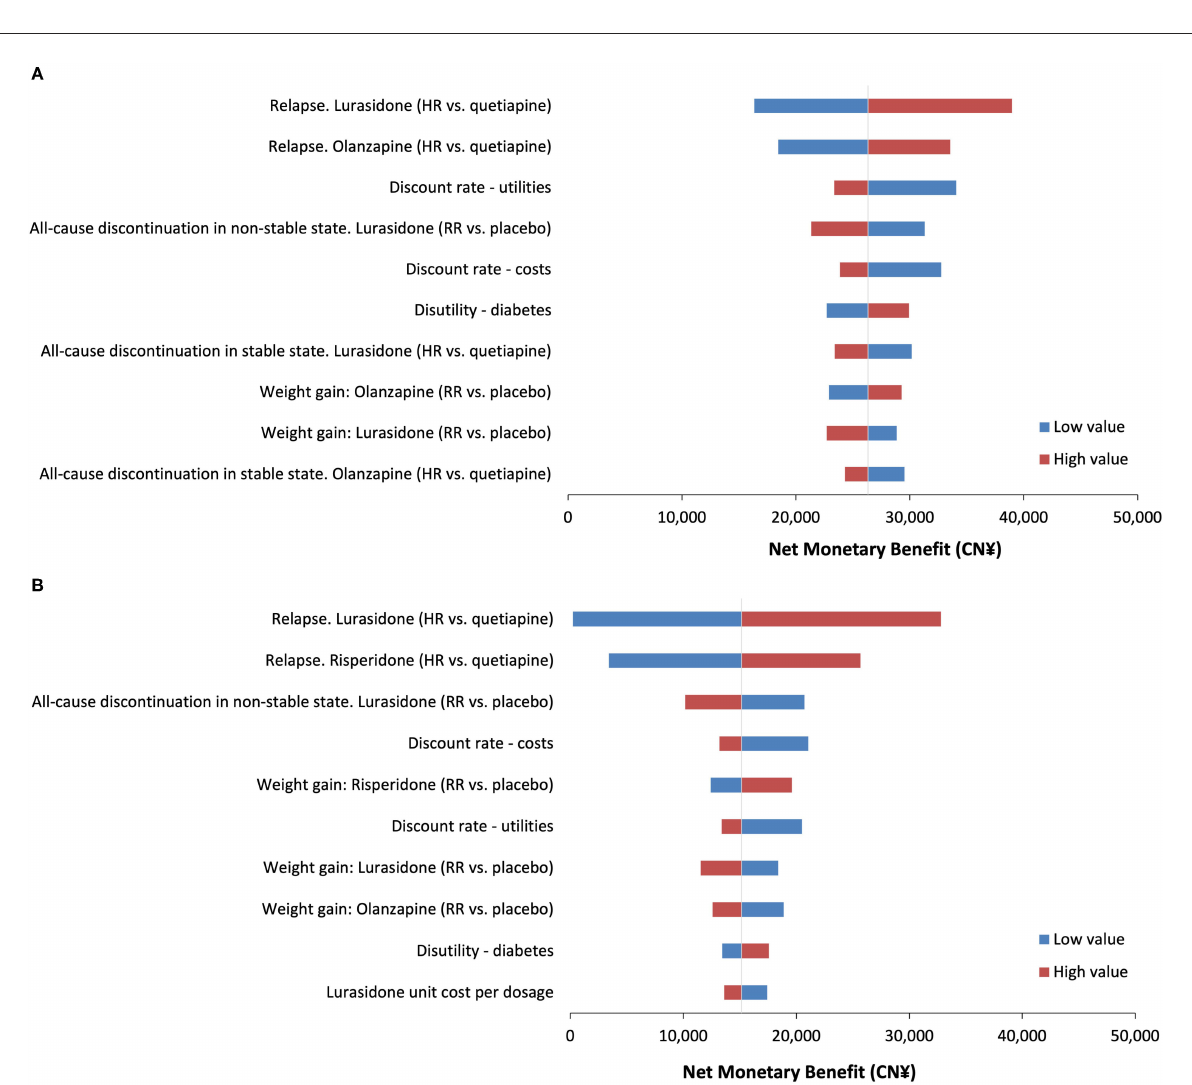
FIGURE2 Tornado diagram for one-way sensitivity analyses. (A) The net monetary benefit for lurasidone vs. olanzapine. (B) The net monetary benefit for lurasidone vs. risperidone. HR, hazard ratio; RR, risk ratio.